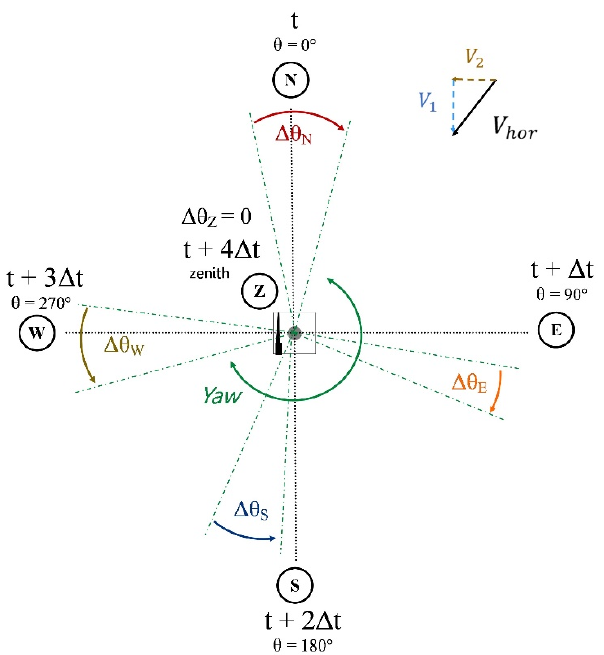
Figure 7. Diagram representation showing the influence of a yaw variation on the angles θ of the five measurement directions of the WindCube v2 ® (top view). The suggested times are added to recall the temporality of the WindCube measurement. The horizontal velocity is decomposed into two components: V 1 and V 2 .